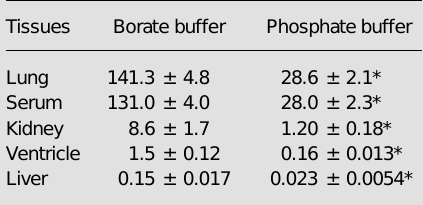
Table 3 - Effect of borate and phosphate buffer on the ACE activity of Wistar rat tissue homogenates. The enzyme activity was assayed as described in Material and Methods. Results are reported as nmol His-Leu min -1 mg protein -1 or nmol His-Leu min -1 ml -1 . Data represent the mean ± SD of three independent experiments. *P<0.01 compared to borate buffer (Student t -test).